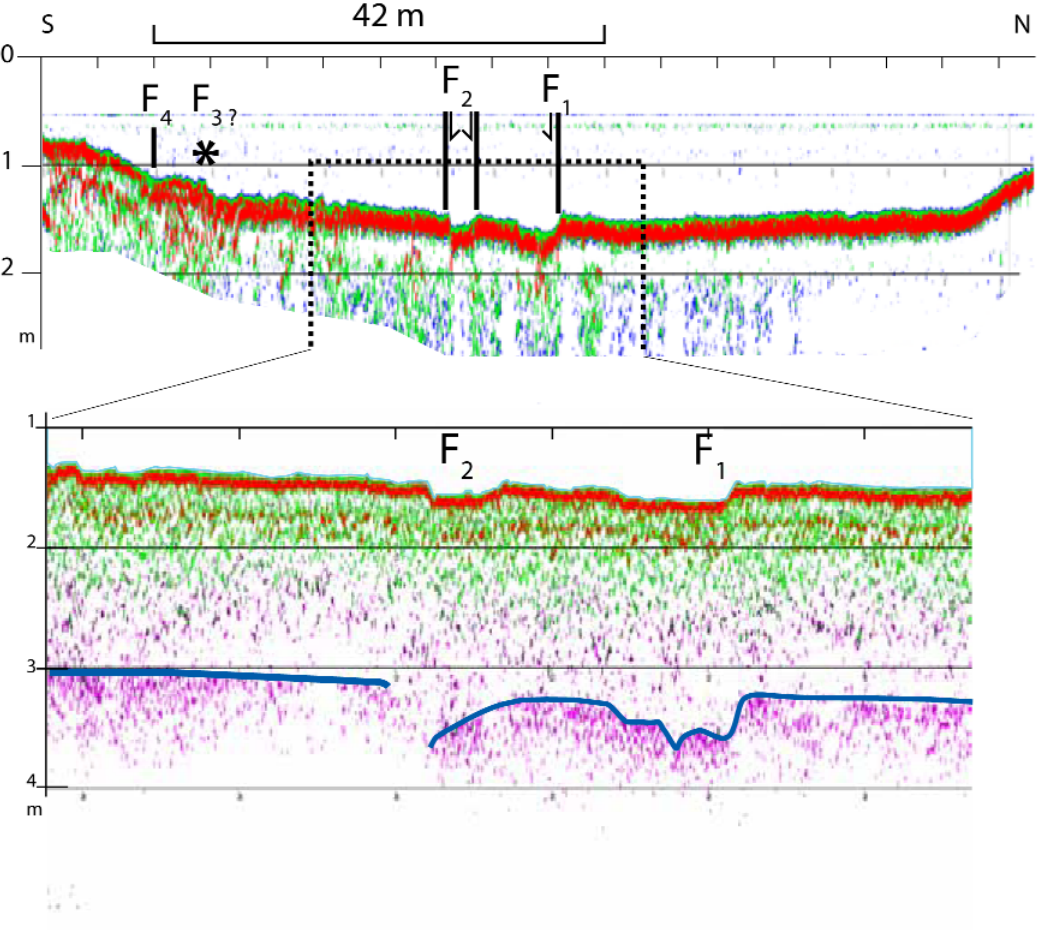
Figure 4. Typical seismic line across A ş a ğ ıtepecik Lake obtained using an Innomar Profiler. The upper panel shows the low frequency signal (6 to 12 kHz), and the lower panel inset shows the high frequency signal (100 kHz). Small fault scarps are still visible in the central part of A ş a ğ ıtepecik Lake, and on its southern margin. The surface fault scarps are 10 cm to 20 cm